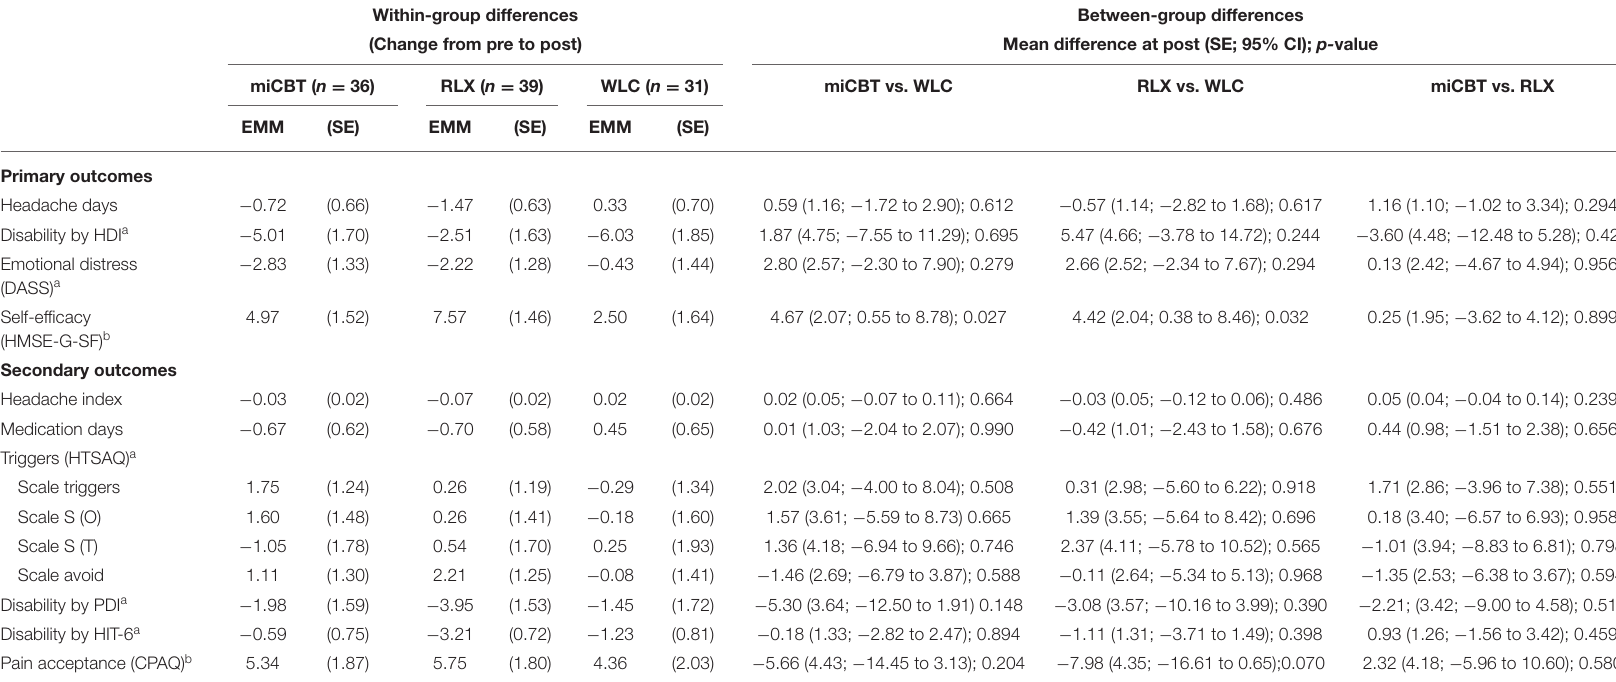
Change from pre to post is based on estimated marginal means (EMM). Mean difference is based on EMM at post-measure. Analyses using linear mixed models for repeated measures, including group, time, and the group x time interaction as fixed factors, and a random intercept to model interindividual differences, based on diagonal covariance matrices and restricted maximum likelihood estimation. Headache days, Headache index, and Medication days each refer to a 28-day period. The HTSAQ comprises 26 triggers. Since two triggers are not listed before, and two triggers (i.e., smoking, menstrual cycle) do not apply to everyone, only the data of 22 triggers was taken into account. miCBT, migraine-specific, integrative cognitive-behavioral therapy program; RLX, relaxation training; WLC, waiting-list control-group; SE, standard error; HDI, Headache Disability Index; DASS, Depression, Anxiety and Stress Scales, total score; HMSE-G-SF, Headache Management Self-Efficacy Scale, German version, Short-Form; HTSAQ, Headache Triggers Sensitivity and Avoidance Questionnaire; S (O), Sensitivity compared with Others; S (T), Sensitivity compared with Time of least sensitivity; PDI, Pain Disability Index; HIT-6, Headache Impact Test; CPAQ, Chronic Pain Acceptance Questionnaire. a Higher values mirror higher burden or higher avoidance. b Higher values mirror higher self-efficacy or higher